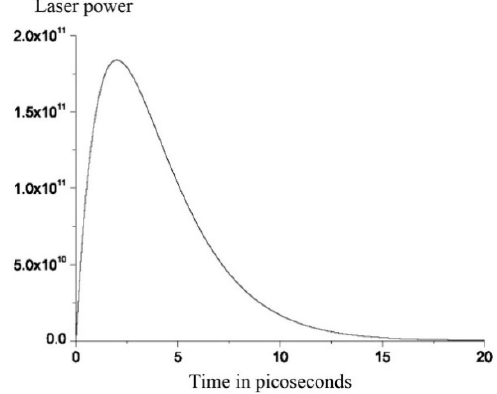
Figure 2. Temporal pro fi le of the laser